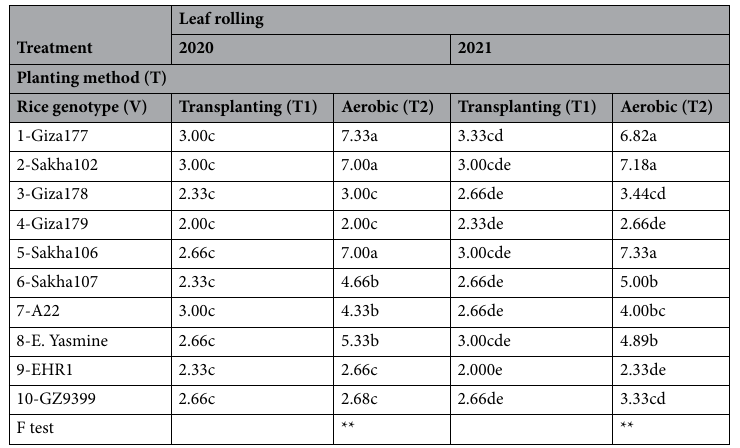
Table 6. Leaf rolling affected by the interaction between the study factors. **Significant at 0.01 level. Means followed by a common letter at the same column are not significantly different according to Duncan ’ s multiple range at 0.05 levels.